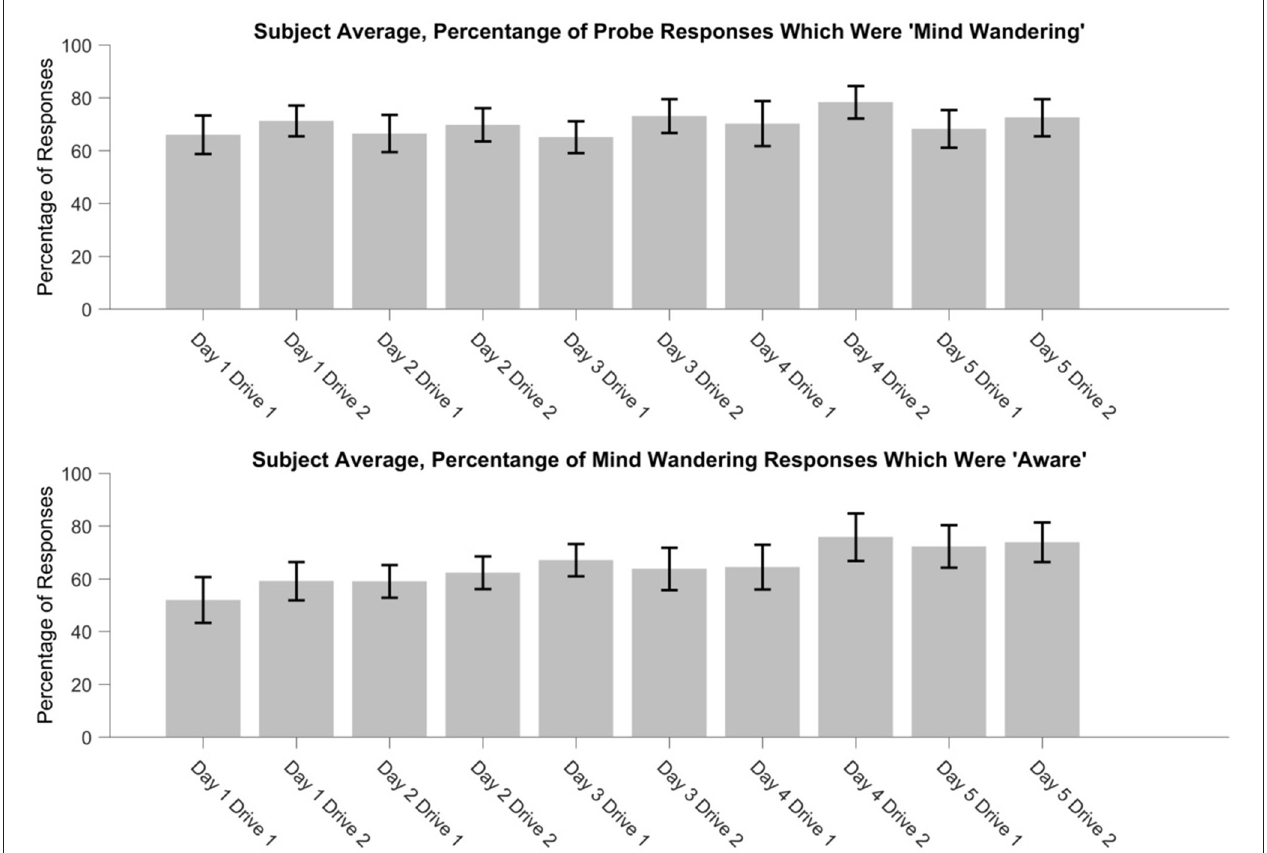
FIGURE 3 | The percentage of attentional probes in which participants responded “mind wandering” (top), and the percentage of “mind wandering” responses that were subsequently categorized as “aware” (bottom), over days and drives.